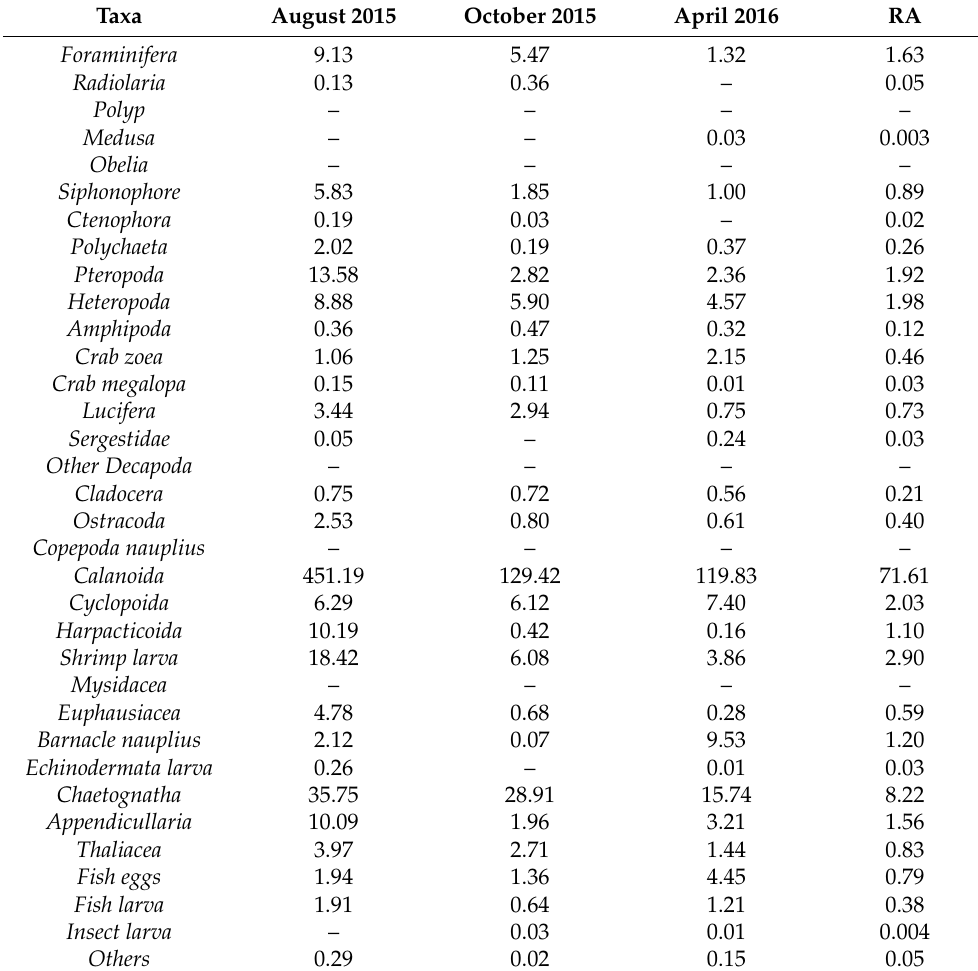
Table 2. Mean abundance (ind. m − 3 ) and total relative abundance (%) levels of zooplankton in the Gaoping waters during the study period. Note: –: no